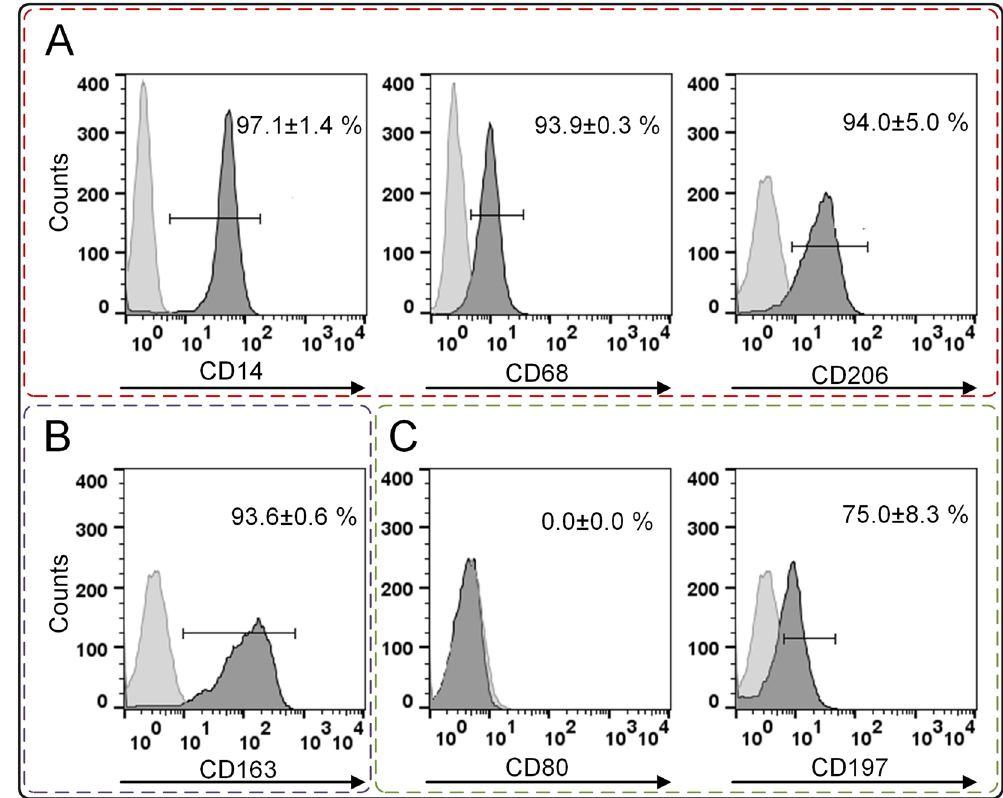
Figure 3. Prior material testing, the differentiation of monocytes to M2-like macrophages was confirmed. ( A ) Macrophage markers CD14, CD68, and CD206 were expressed. ( B ) The differentiation towards a M2- like phenotype was shown by CD163 positive profile, whereas ( C ) CD80 allowed distinguishing between M1 and M2. Here, its absence rejected the M1 differentiation. The marker CD197 was expressed by macrophages differentiated from whole-blood-derived monocytes. Histograms exemplarily represent the differentiation cluster of one donor; whereas mean values ± SD represent data of three blood donors. A high compliance between all three donors was found. The light-grey histograms represent the isotype controls. The following abbreviations are used: SD for standard deviation, CD for cluster of